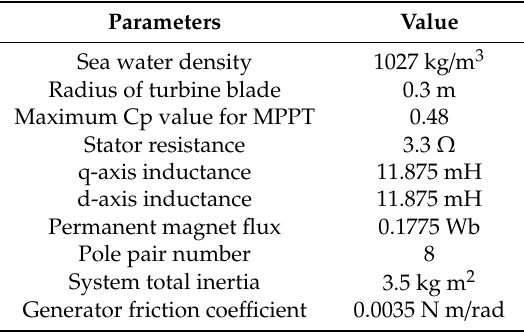
Table A1. System parameters